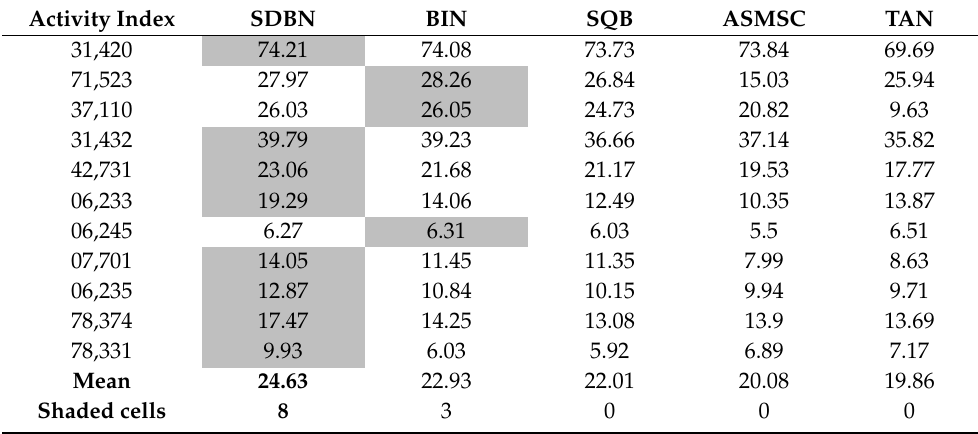
Table 4. Retrieval results of top 1% for MDDR-DS1 dataset.